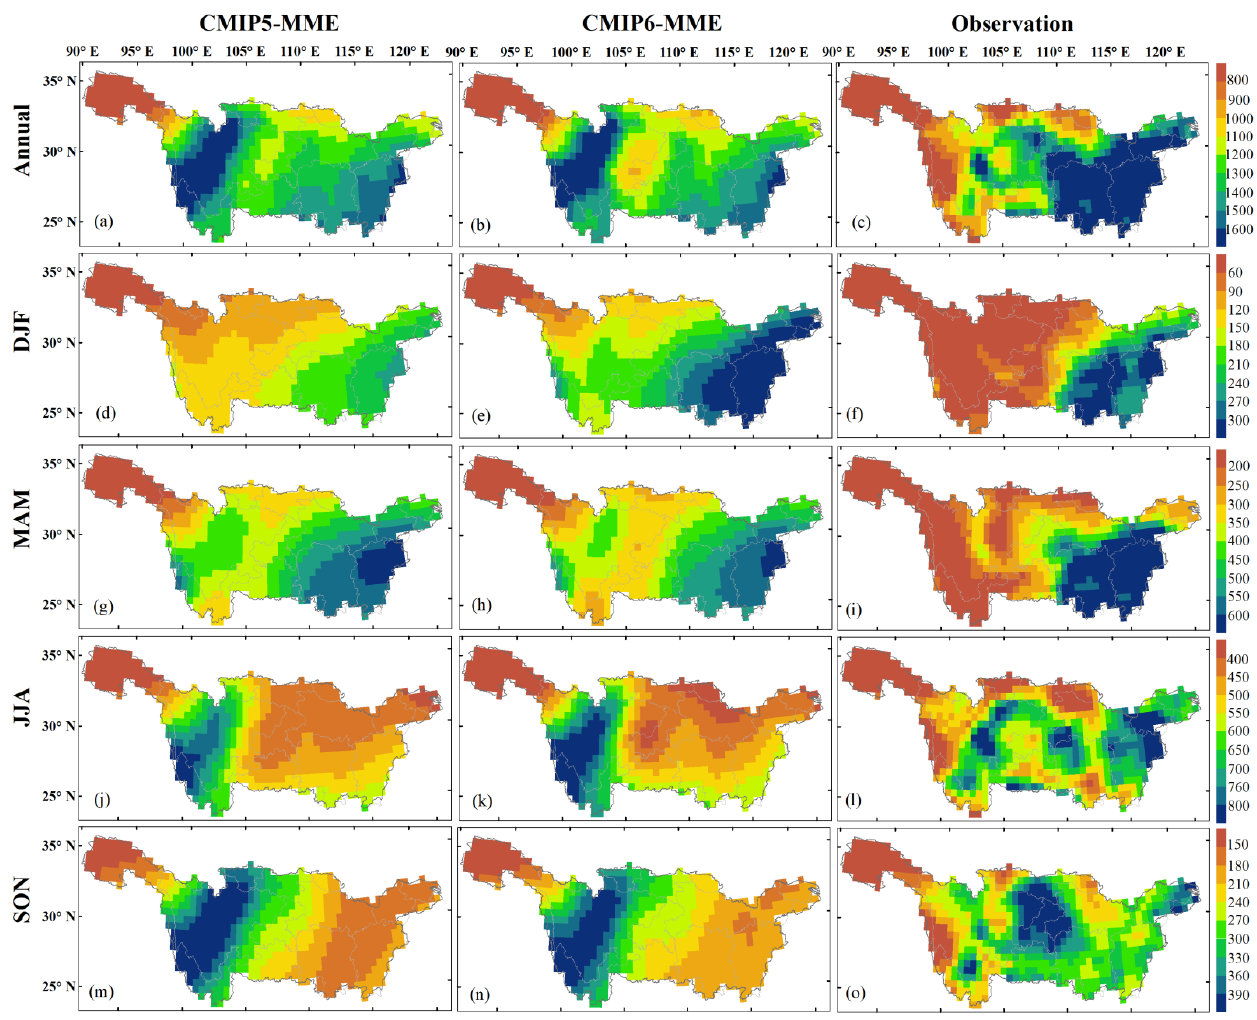
Figure 2. Precipitation (mm) of the CMIP5-MME data, the CMIP6-MME data, and the observed data in annual ( a – c ), DJF ( d – f ), MAM ( g – i ), JJA ( j – l ), and SON ( m – o ) from 2015 to 2020.